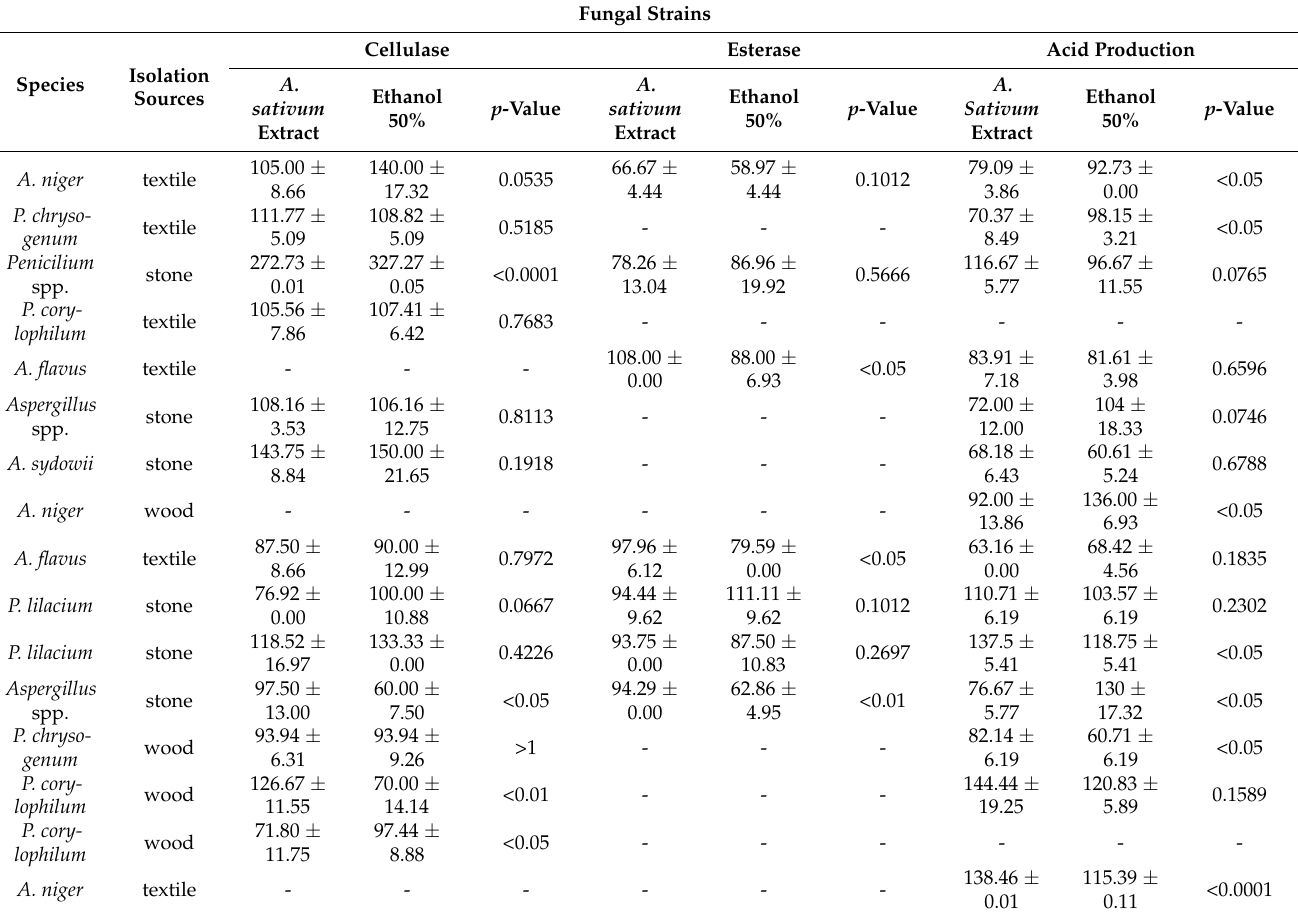
Table 4. The influence of A. sativum extract and ethanol (50%) control on the production of enzymatic factors involved in